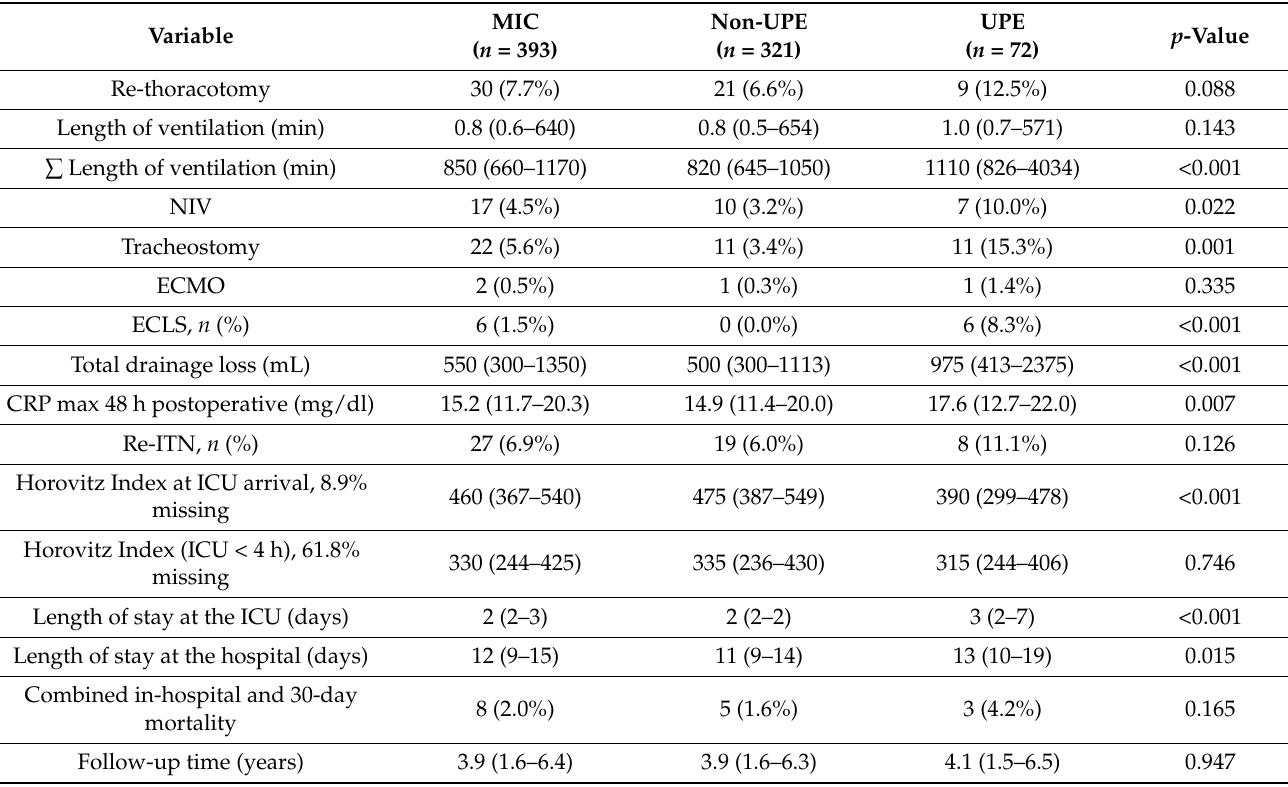
Table 3. Postoperative details of MIMVS